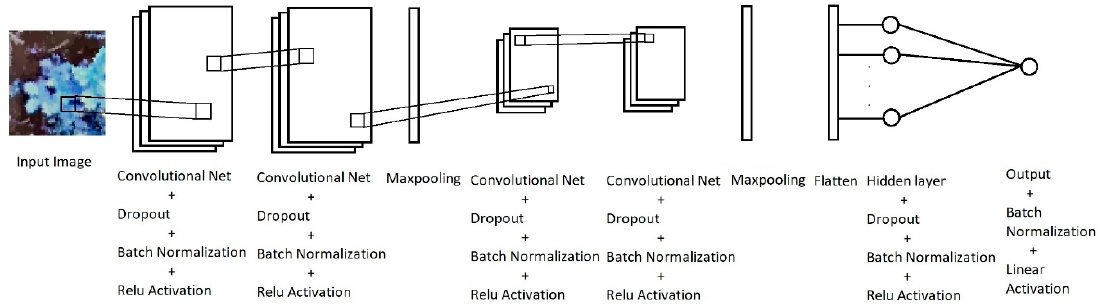
Figure 4. Convolutional neural network architecture indicating in detail each one of the convolutional and hidden layers.